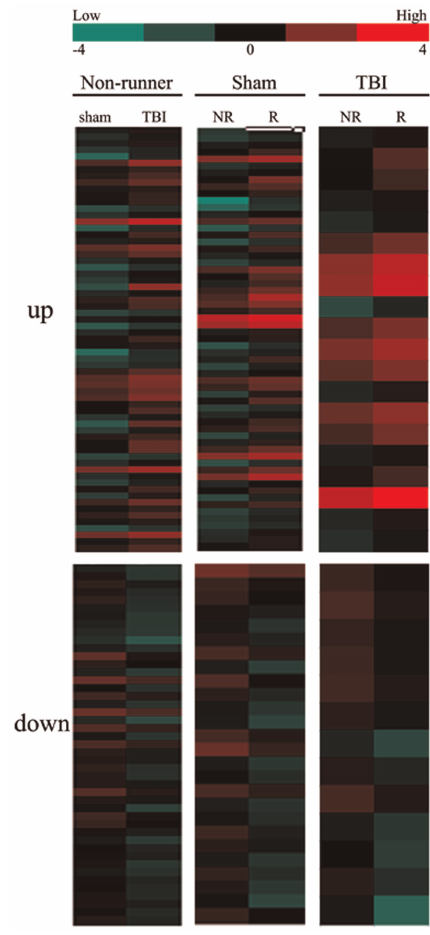
Figure 1. Percentage survival of traumatic brain injury (TBI) mice pre-treated with running wheel (RW) exercise. The number of mice pre-treated with voluntary RW that died during the 14-day post- injury follow-up period was significantly lower compared to those from injury control (TBI-non- runner) (log-rank test, *chi-square=6.341, P= 0.0278 compared to TBI-non-runner). The results indicated that pre-treatment of traumatized mice with RW reduced the mortality rates significantly.